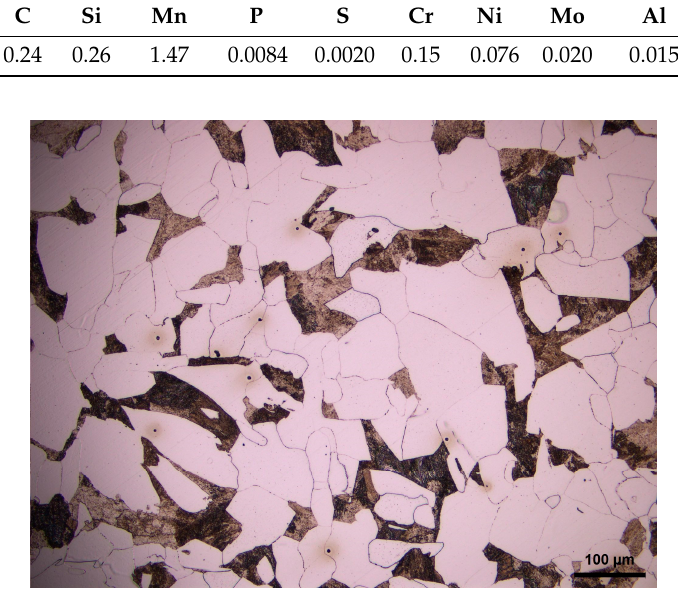
Figure 1. The initial as-cast microstructure of 20Mn5 steel.